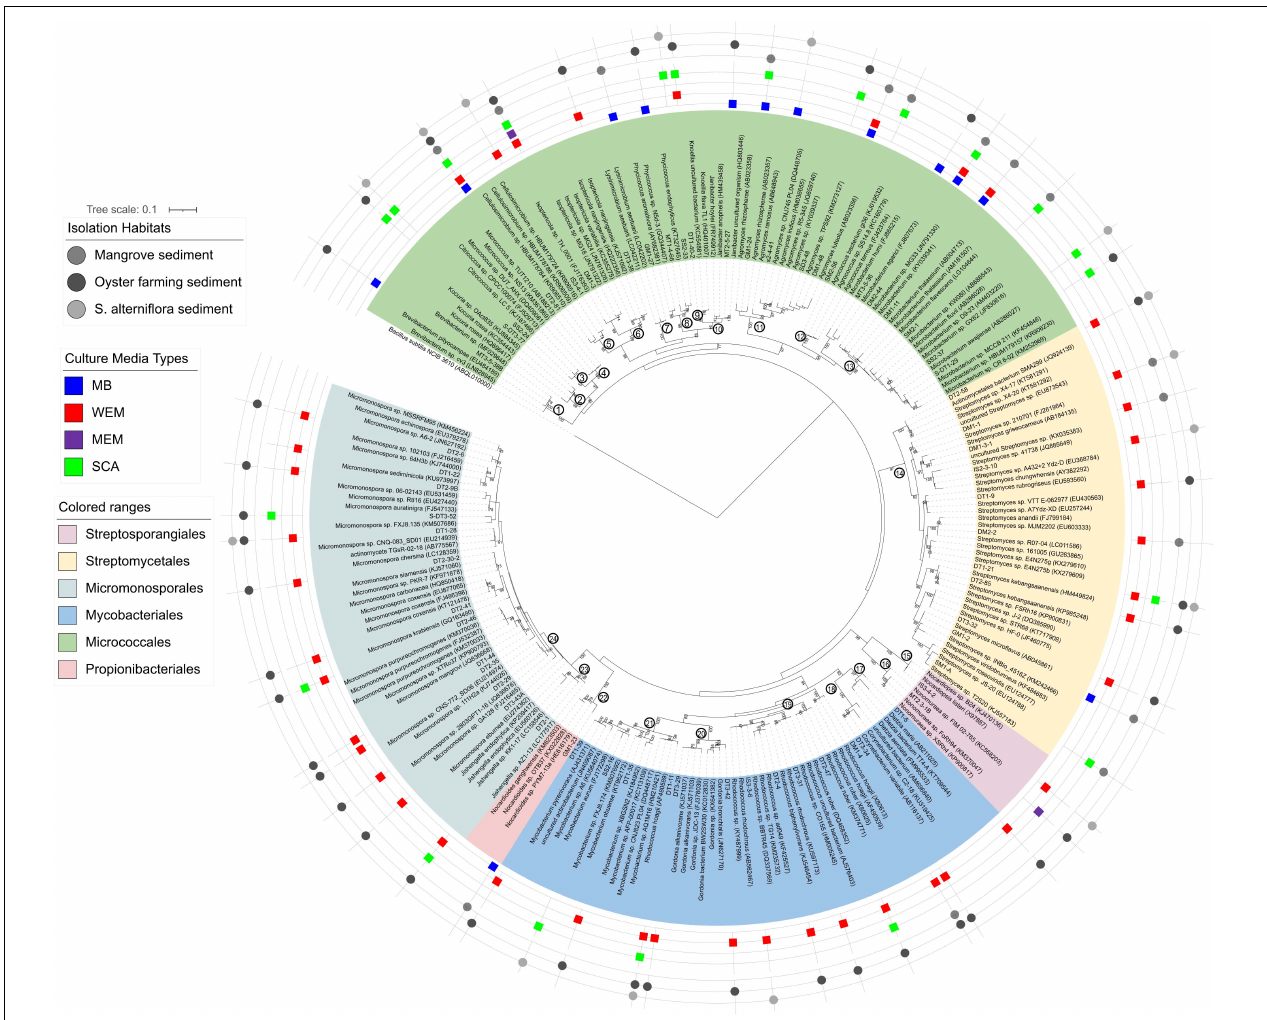
FIGURE 3 | Maximum-likelihood phylogenetic tree based on the 16S rRNA gene sequences of actinobacterial isolates obtained from the three habitats using four culture media. Bootstrap values ( > 70) after 100 resampling are shown above the tree branches. Bar, 0.1, estimated nucleotide substitution. Numbers in the circle at the node of each clade represented the genus name: 1, Brevibacterium ; 2, Kocuria ; 3, Citrococcus ; 4, Micrococcus ; 5, Cellulosimicrobium ; 6, Isoptericola ; 7, Lysinimicrobium ; 8, Phycicoccus ; 9, Knoellia ; 10, Janibacter ; 11, Agromyces ; 12, Agrococcus ; 13, Microbacterium ; 14, Streptomyces ; 15, Nocardiopsis ; 16, Non-omuraea ; 17, Dietzia ; 18, Corynebacterium ; 19, Rhodococcus ; 20, Gordonia ; 21, Mycobacterium ; 22, Nocardioides ; 23, Jishengella ; 24, Micromonospora